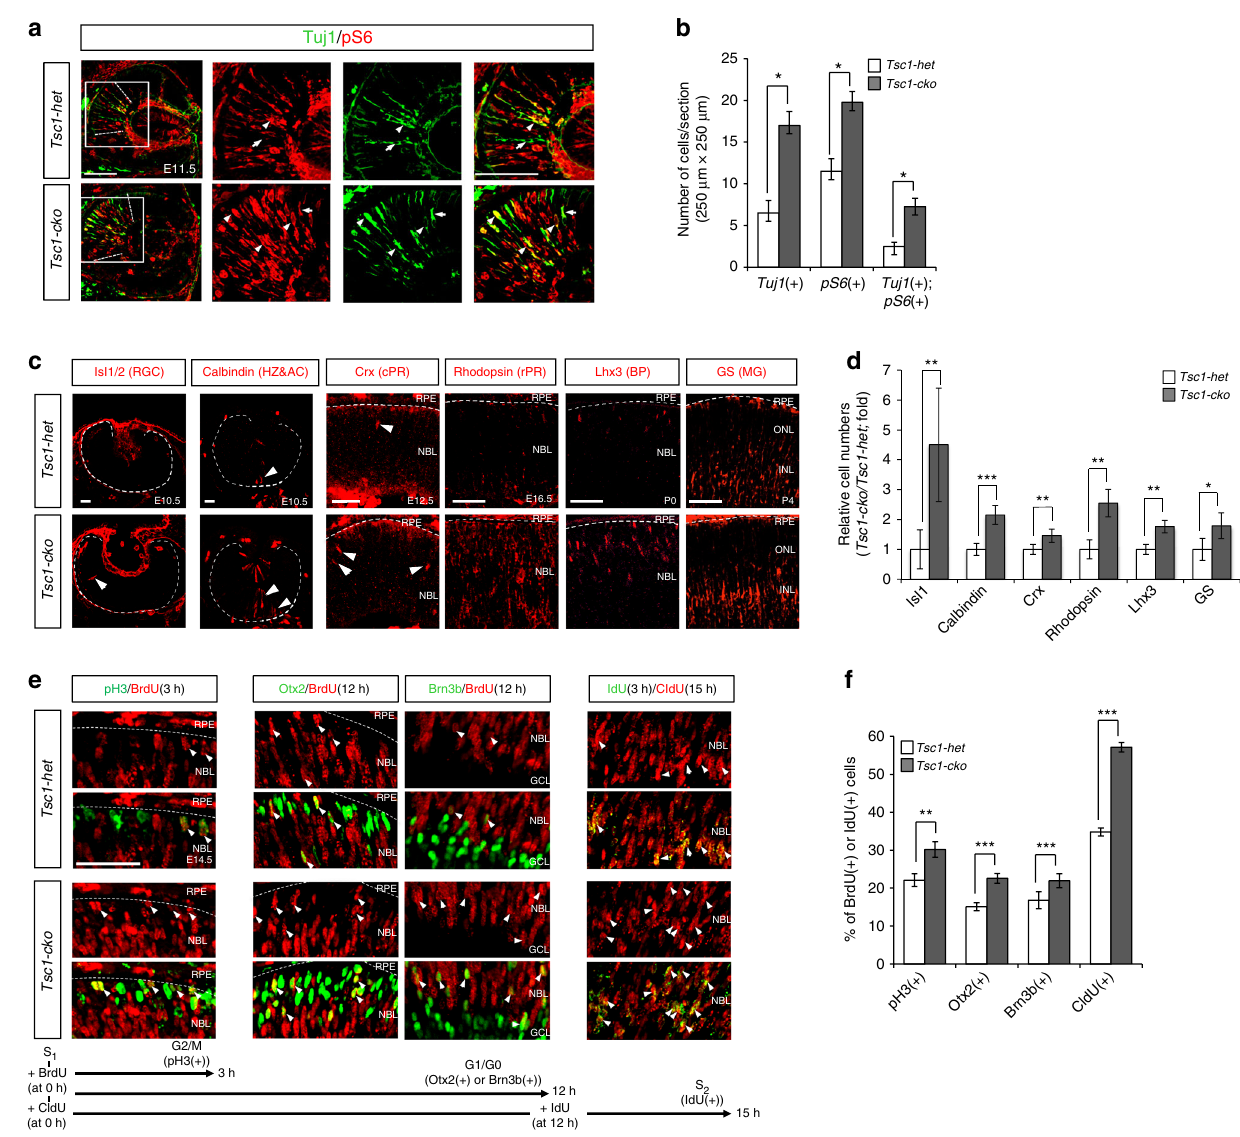
Fig. 2 mTORC1 activation accelerates RPC cell cycle and retinal development. a E11.5 Tsc1-het and Tsc1-cko littermate mouse retinal sections (coronal, 12 μ m) were co-stained with mouse anti-tubulin- β III antibody (Tuj1; green) and rabbit anti-pS6 antibody (red). Images in three right columns are corresponding to the lined boxes in the left. Dotted lines indicate dorsal (top) and ventral (bottom) margins of Tuj1-positive cell population. Scale bar, 100 μ m. b Numbers of stained retinal cells in an area (250 μ m × 250 μ m) were shown in a graph. Numbers ( n ) of retinas analyzed are 5 obtained from 3 independent litters. c Distribution of retinal neurons in littermate Tsc1-het and Tsc1-cko mouse retinas at corresponding time points, when each retinal subtype is produced prominently, was analyzed by immunostainings of various cell type-speci fi c markers. Dotted lines mark retina-RPE borders. Arrowhead indicates marker-positive post-mitotic neurons. Scale bar, 100 μ m. d Relative numbers of retinal cells in the Tsc1-cko mice were compared with those in Tsc1-het mice and shown in a graph. Numbers of samples analyzed are 6 (E10.5, E12.5 and E16.5) and 4 (P0 and P4) prepared from 4 and 3 independent litters, respectively. e Pregnant female mice were injected with BrdU (5 mg/kg) at 3 h (for pH3 co-staining) or 12 h (for Otx2 or Brn3b co- staining) prior to the collection of embryos at 14.5 dpc. Alternatively, mice were injected with CldU and IdU at 15 and 3 h prior to the collection of the embryos, respectively. Retinal sections were then co-stained with rat anti-BrdU (red) and corresponding rabbit antibodies (green) for the former analyses, and mouse anti-CldU (green) and rabbit anti-IdU (red) antibodies for the latter analysis. Arrowheads indicate cells co-expressing BrdU and corresponding markers. Scale bar, 50 μ m. f Ratio of BrdU-co-expressing cells to total marker-expressing cells was obtained from 5 different samples from 3 independent litters and shown in a graph. Values in the graph are average and error bars are SD. P -values are obtained by Student ’ s t -test and shown in the graphs (*<0.05; **<0.01; ***<0.001) fl ox/ fl ox generated Tsc1 ; Chx10-Cre ( Tsc1-cko ) mice lacking Tsc1/ greatly elevated in the Tsc1-cko mouse retina in comparison to Hamartin, which cooperates with Tsc2/Tuberin to inhibit Tsc1 fl ox/ + ; Chx10-Cre ( Tsc1-het ) littermate mouse retina (Fig. 1a, fl ox/ b; there was no phenotypic difference among Chx10-Cre , Tsc1 Rheb1-dependent activation of mTORC1 speci fi cally in the fl ox ( Tsc1- fl ox ), and Tsc1-het mice [data not shown]). Overall size retina 18, 19, 23, 24 . Consequently, mTORC1 activity, measured indirectly by detecting the phosphorylation of ribosomal S6 of the eye of Tsc1-cko mice was not different signi fi cantly from protein at S235/S236 (pS6) by an mTORC1 target S6 kinase, was Tsc1-het littermates, although the retinas of Tsc1-cko mice were NATURE COMMUNICATIONS| (2018) 9:2502 |DOI: